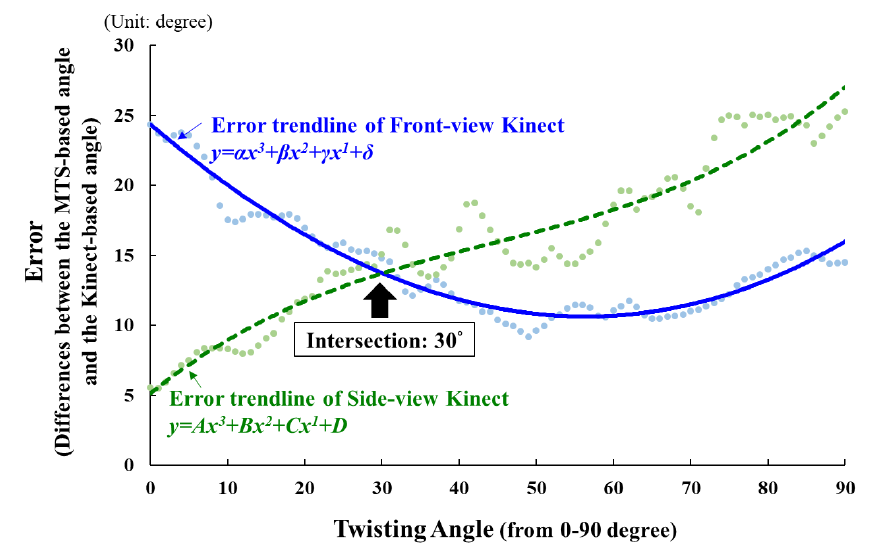
Figure 3. An example of our proposed method: the error trendlines of the Front-view Kinect ( — ) and the Side-view Kinect ( ---- ) for tracking each upper-limb joint angle trajectory are used to find the intersection point between the two tracking error trajectories. The intersection point can be defined as the optimal data selection point for switching the sensor’s viewing angle. For example, in this figure, the data of the Integration Kinect are based on the 0° to 29° duration joint angle data from the Side-view Kinect and the 30° to 90° duration data from the Front-view Kinect.